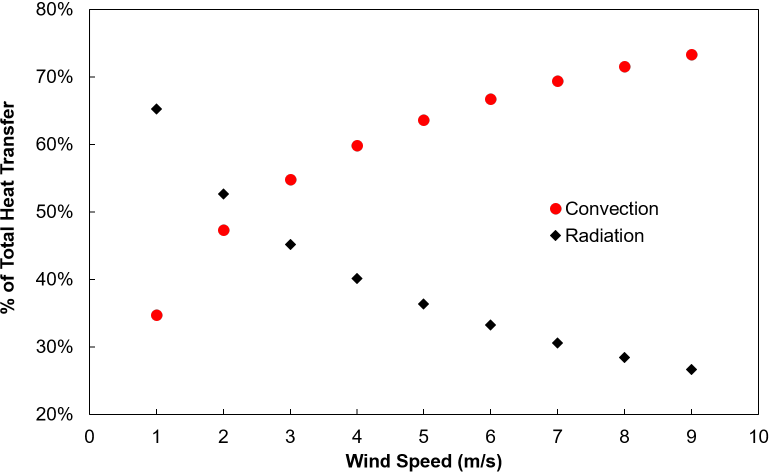
Figure 13. Contribution of radiative and convective heat transfer as a percentage of total heat transfer at various wind